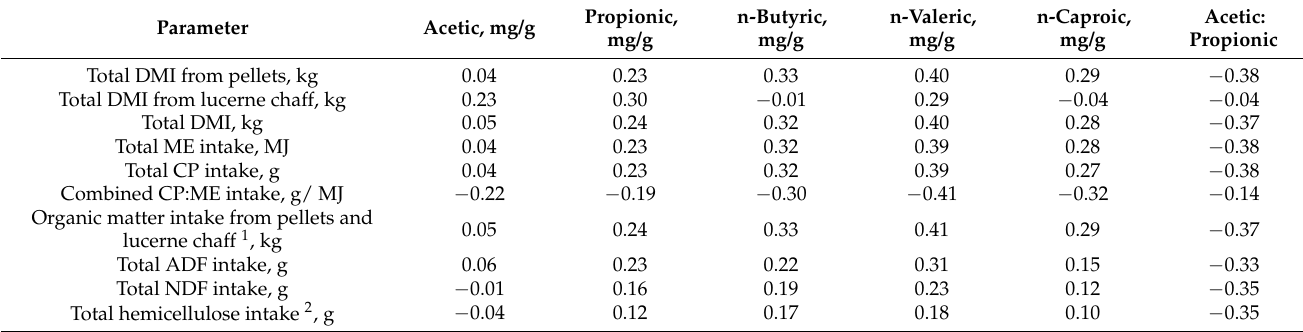
Table A1. Pearson correlation coefficients of dietary factors and rumen metabolic development parameters of artificially reared lambs given three rearing treatments (DMI, dry matter intake; ME, metabolisable energy; CP, crude protein; ADF, acid detergent fibre; NDF, neutral detergent fibre).